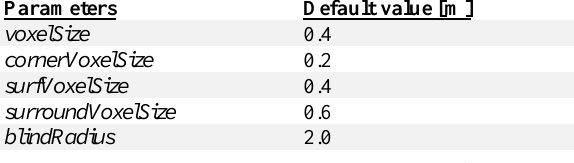
Table 3. Setting Kaarta Stencil 2 parameters input for outdoor